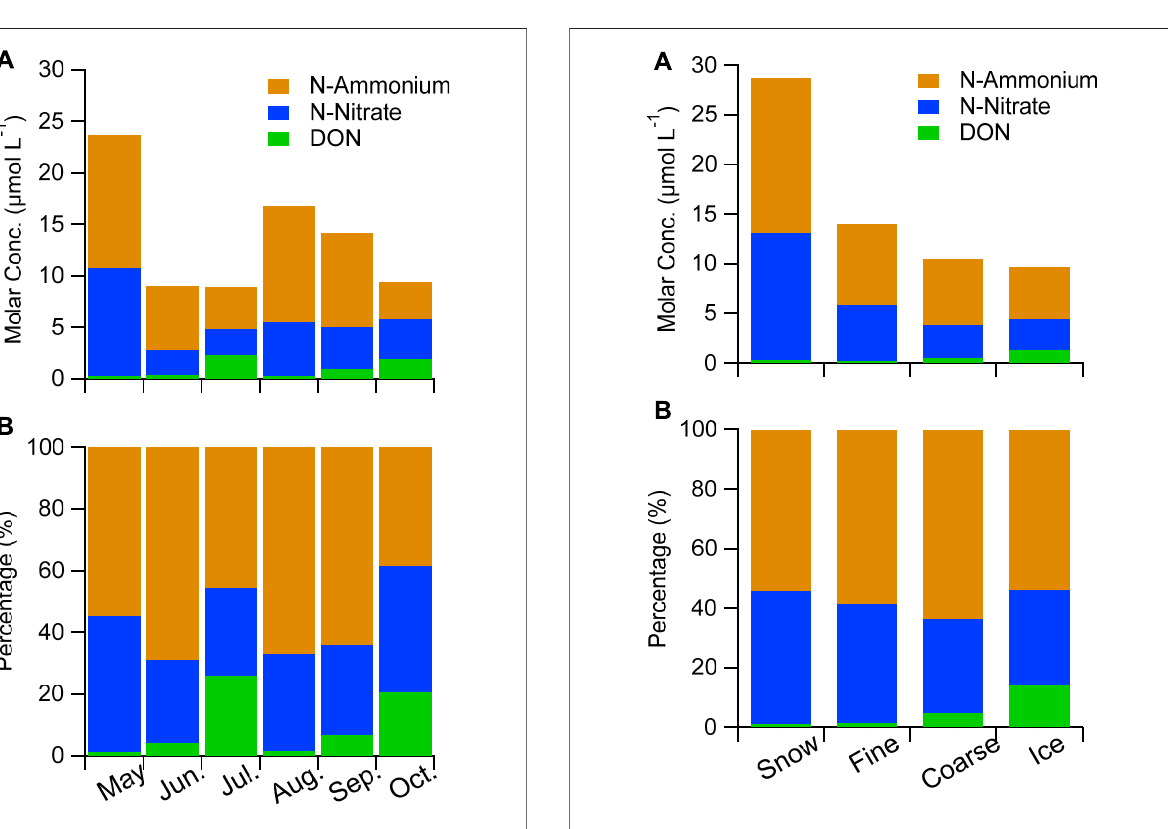
FIGURE 3 | (A) Monthly mean total dissolved nitrogen concentrations (µmol L − 1 ) and (B) molar contribution of different nitrogen species in the samples collected from the DKMD Glacier. The samples were collected from May to October in 2015 one time each month along the mainstream of the glacier.